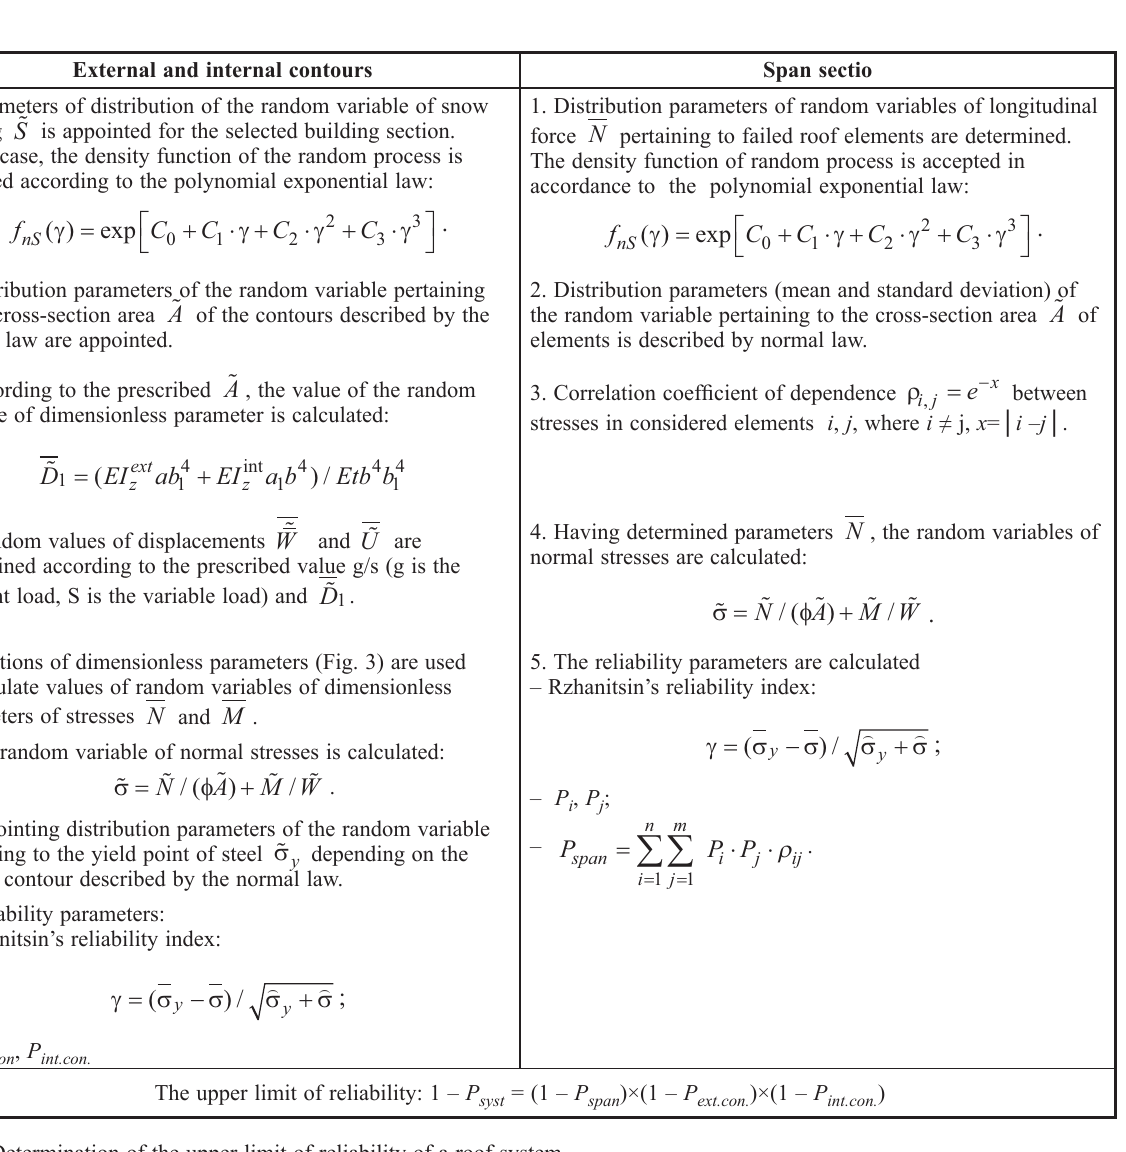
Fig. 5. Determination of the upper limit of reliability of a roof